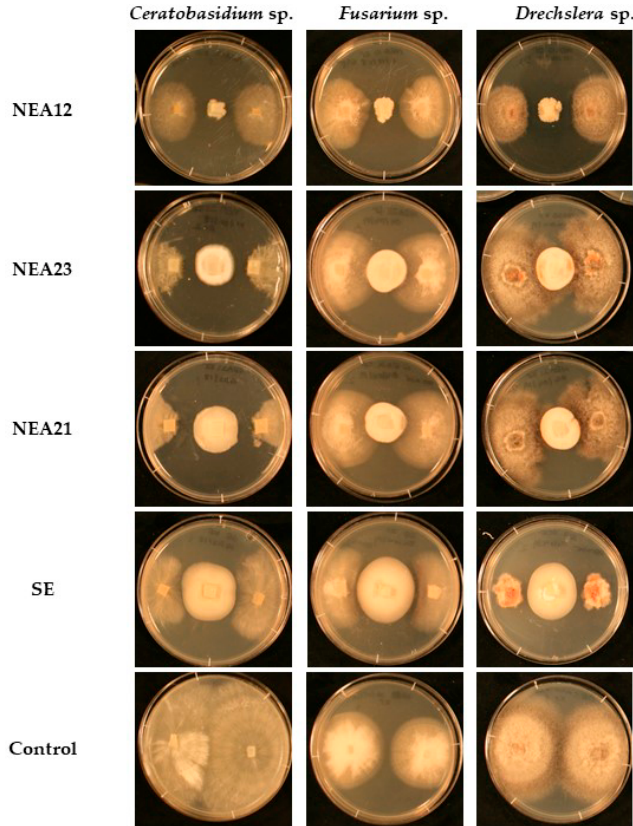
Figure 1. Dual culture assay for growth inhibition of pathogens Ceratobasidium sp., Fusarium sp ., and Drechslera sp. by four Epichloë spp. strains (in rows) NEA12 ( n = 5), NEA23 ( n = 5), NEA21 ( n = 5), SE ( n = 5) and negative control (pathogen alone) ( n = 5) observed on day five of the bioassay. The images are of a typical representative of the five replicates. Refer to Figures S1, S2, and S3 for the temporal profile.